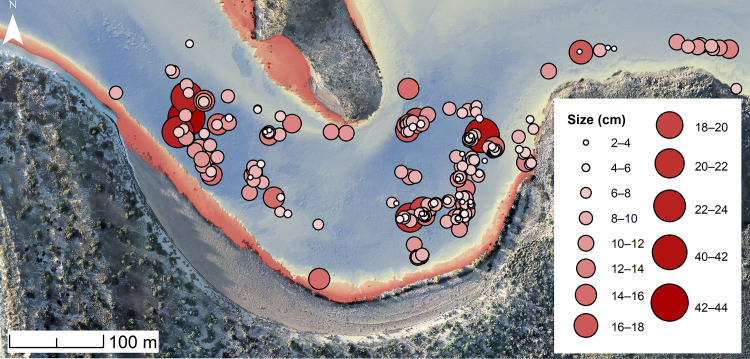
All finds with an associated measurement (as described in Table 2) were plotted on the LiDAR bathymetry in Cape Bruguieres Channel, and the symbols altered to suit a gradient of smallest to largest recorded artefacts.The distribution of the finds indicates no relationship between depth and artefact size.